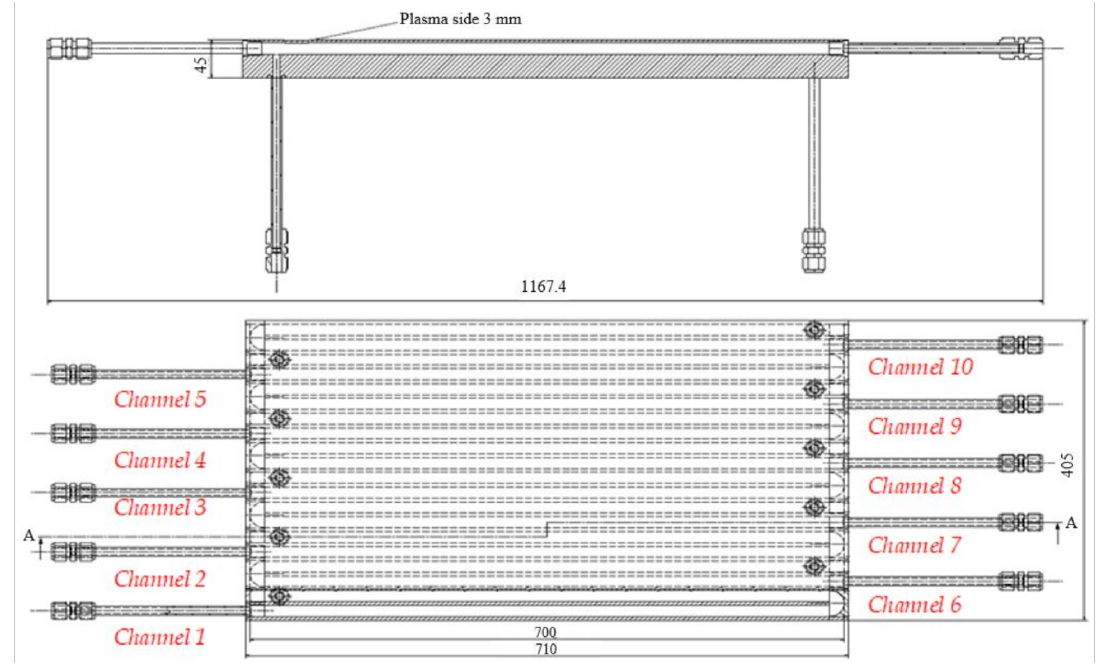
Figure 1. The First Wall